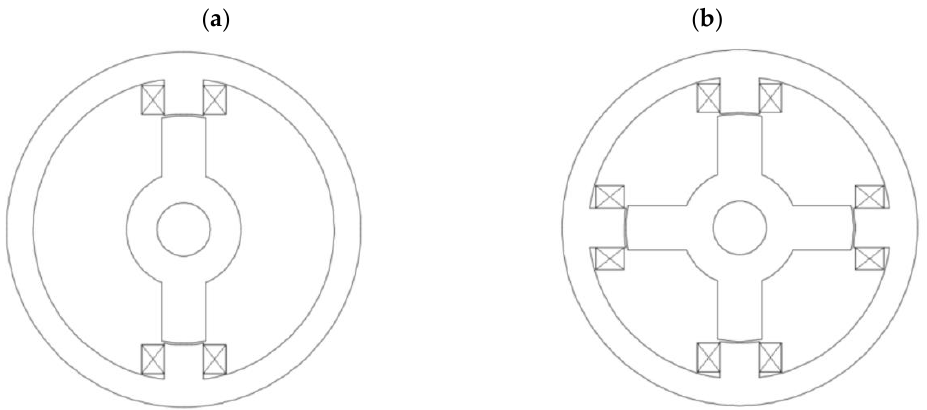
Figure 3. Exemplary cross-sections of different single-phase reluctance motor types: ( a ) 2/2; ( b ) 4/4, number of pole pairs per phase p = 2.